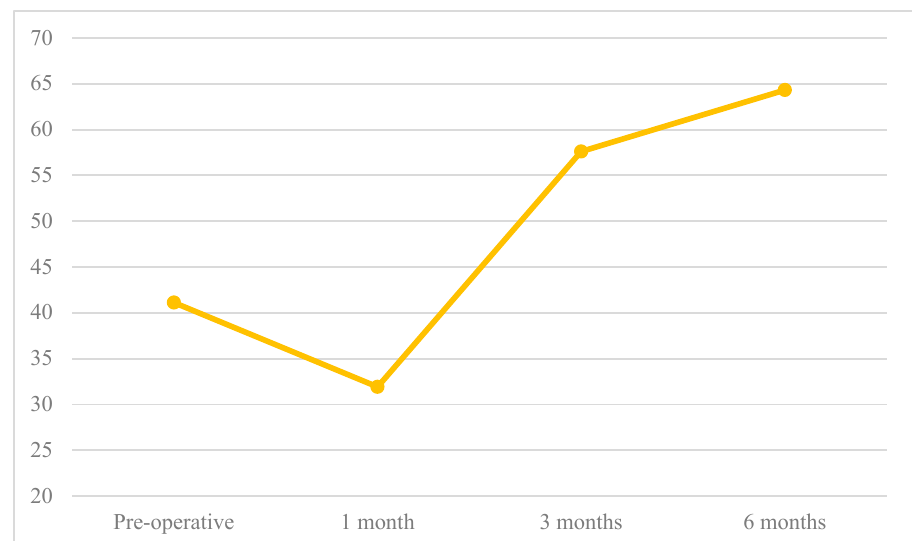
Figure 2. Constant Score follow-up.